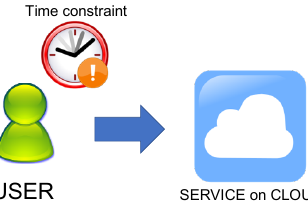
Figure 1. An application scenario including user-generated